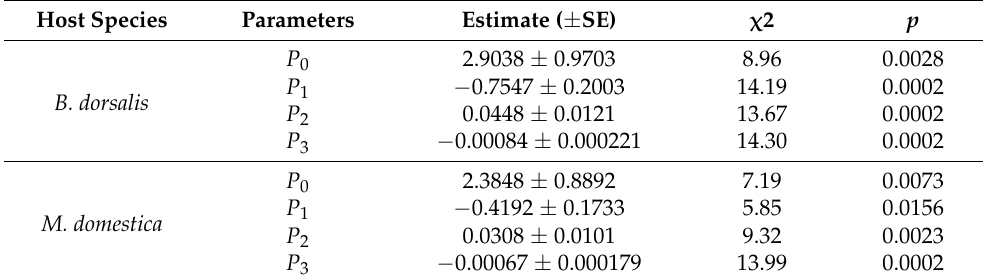
Table 1. Maximum likelihood analysis of the functional response for the proportion of different hosts parasitized by S. endius